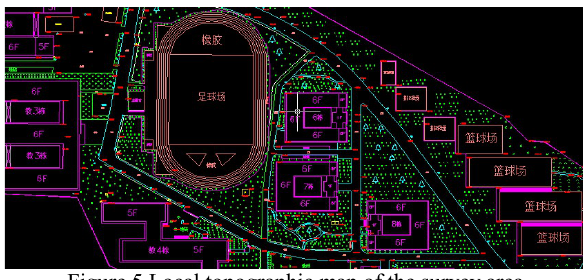
Figure 7 Surface Fitting Method Accuracy Comparison